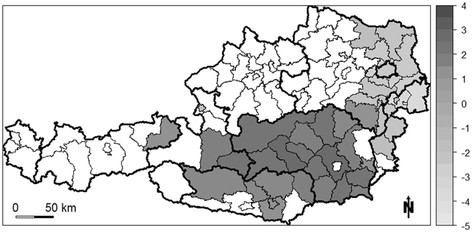
Significant localG*-statistic for suicide SMR (for multiple comparisonsp-values are adjusted [[19], non-shaded districts are not significant).